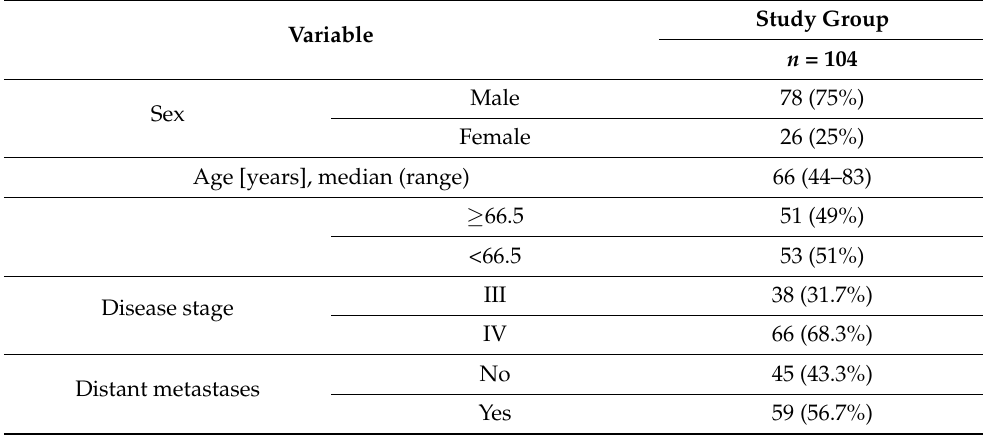
Table 1. Characteristics of the study